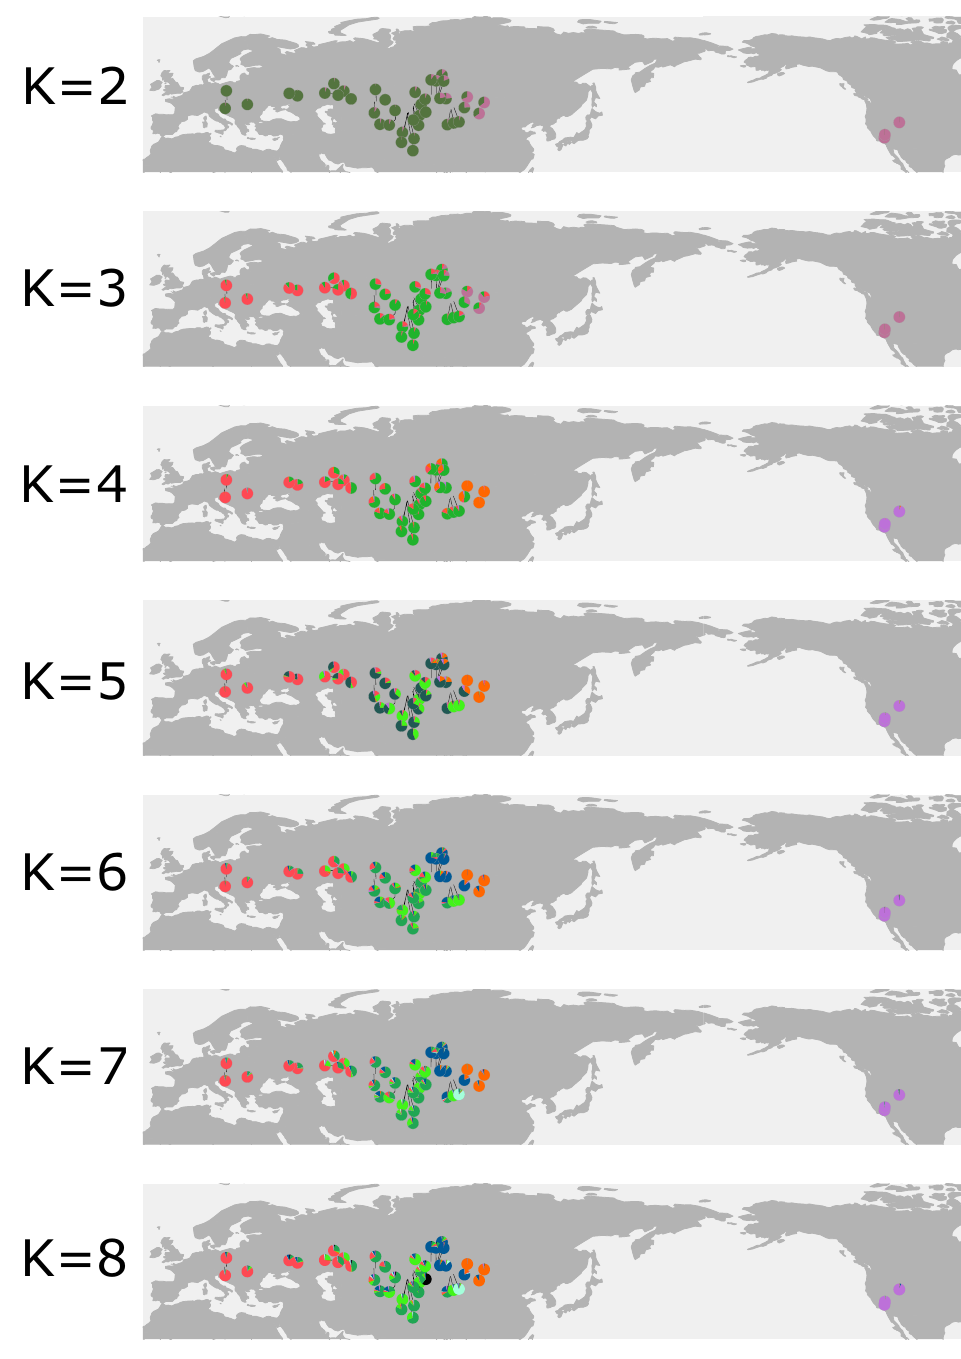
Figure 3. Genetic clustering of samples as inferred from LEA is shown as pie charts for K=2 to K=8 clusters. The first split occurred in Central Asia, dividing the populations west and east of the Khangai Mountains (K=2), followed by a split in the area of the Ural Mountains (K=3). At K=4, the American populations separate; at K=5, the diploids and tetraploids of Middle Asia and adjacent areas each form their own group. At K=6, the populations of the Altai Mountains form their own cluster. At K=7 and K=8, P238 and P081 form their own cluster. The map was generated in R using the packages ‘mapplots’ (https:// CRAN.R- proje ct. org/ packa ge= mappl ots) and ‘rworldmap’ (http:// journ al.r- proje ct. org/ archi ve/ 2011-1/ RJour nal_ 2011-1_ South. pdf) and was edited in Inkscape v1.0.2 (https:// inksc ape.